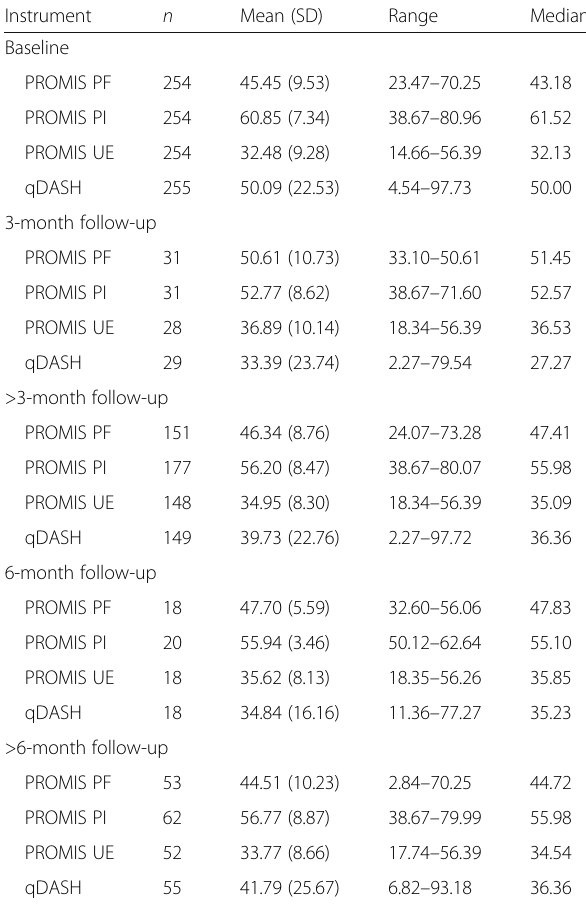
Table 2 Descriptive statistics of PROMIS instruments and qDASH of